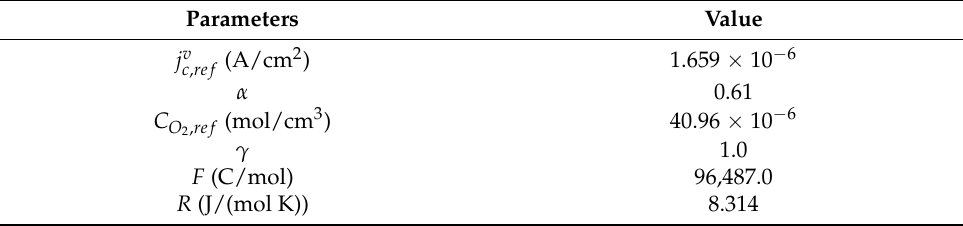
Table 2. Model parameters [35,39].